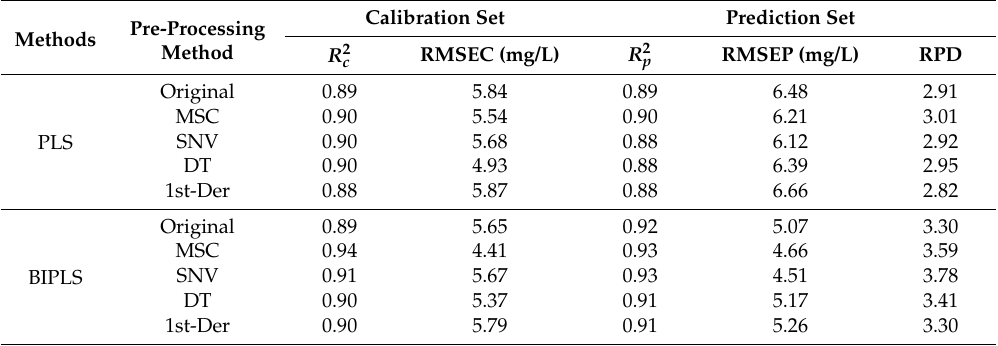
(Figure 7a: calibration set; Figure 7b: prediction set), revealing that the deltamethrin in strawberry could be quantitatively determined by SERS based on